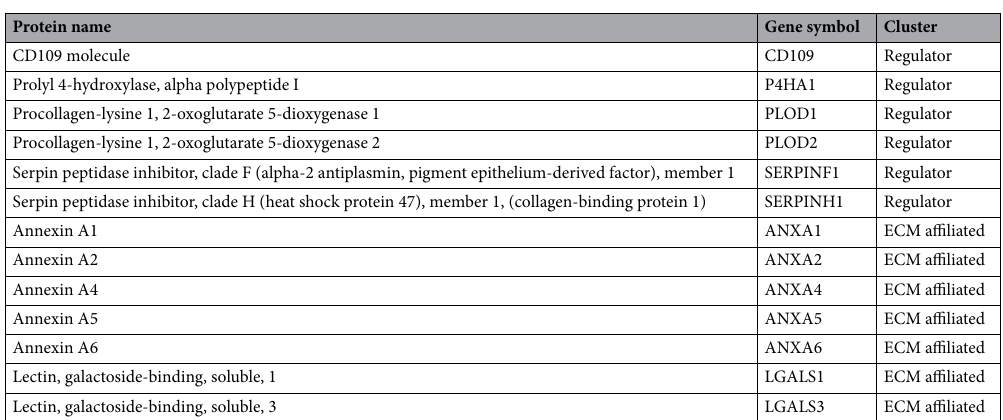
Table 1. Protein list of interest. Table lists the proteins of interest (uniquely expressed in fetus in at least 4 samples, significantly upregulated in fetus or upregulated > twofold if only 1 sample expressed the respective protein in the healthy adult group).